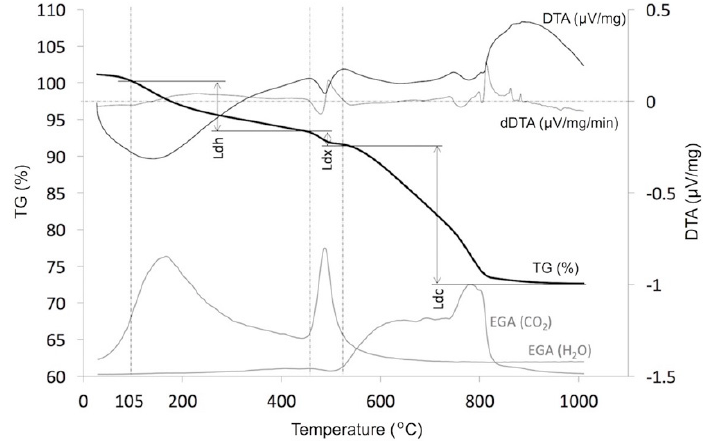
Figure 2. Sample TG/DTA and EGA curves as functions of temperature.